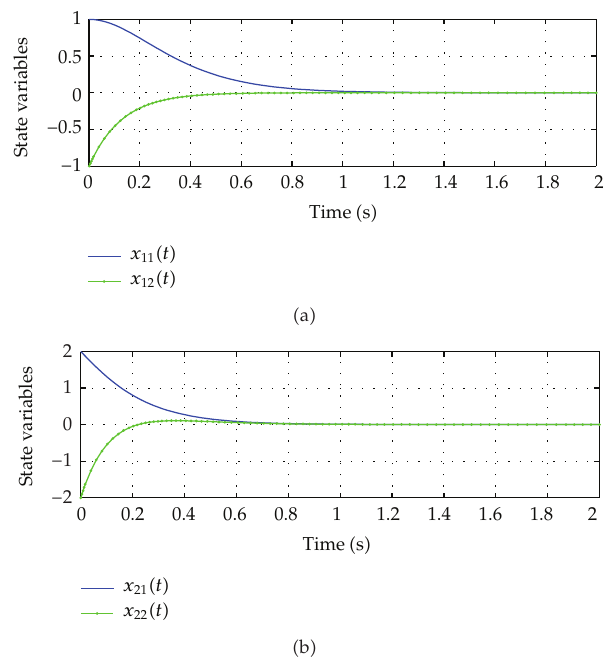
Figure 3: The state response with fuzzy control by Theorem 3.4.